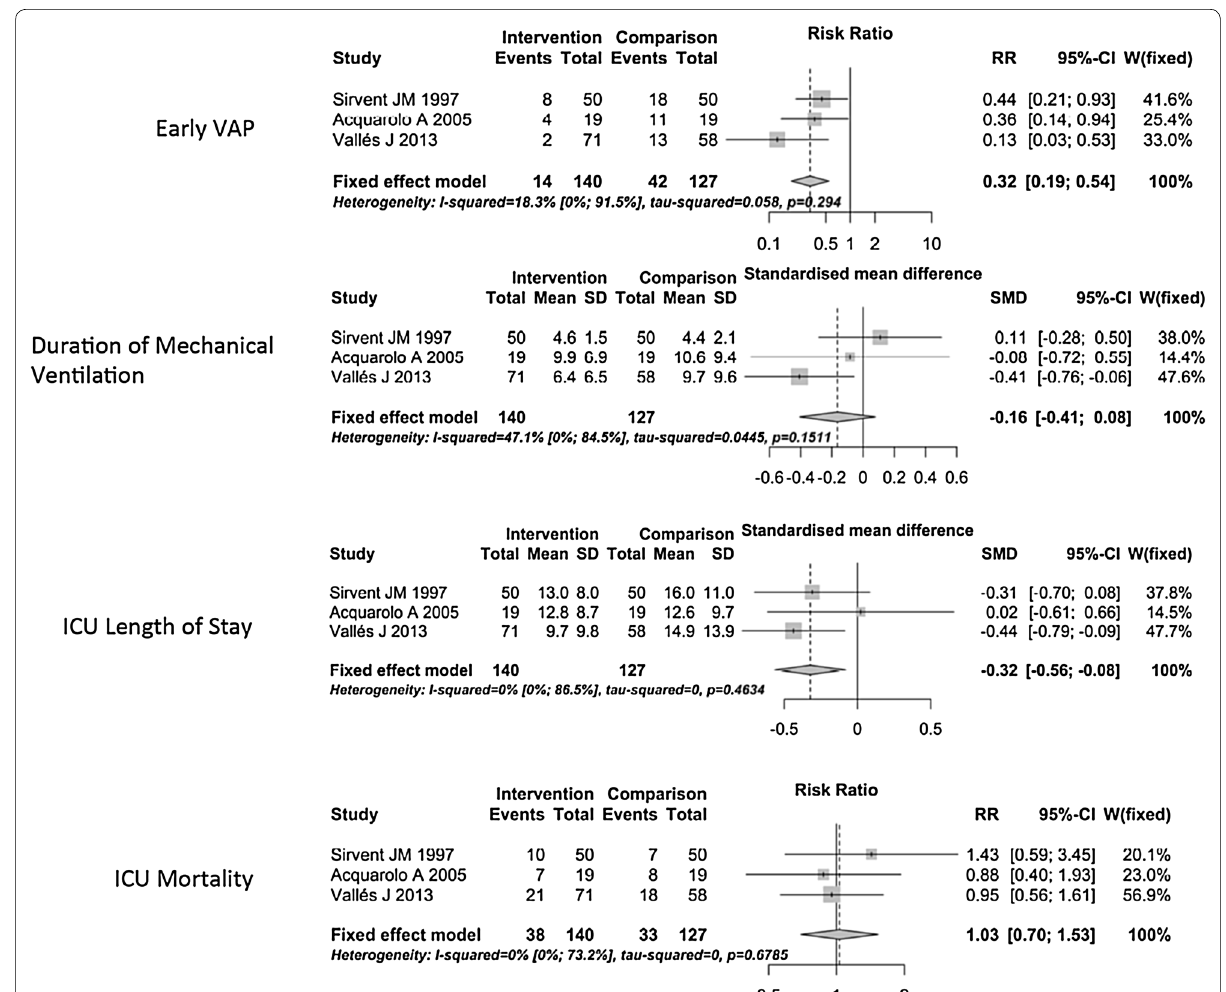
Fig. 2 Impact of antibiotic prophylaxis on early VAP, ICU mortality, duration of mechanical ventilation, and ICU length of